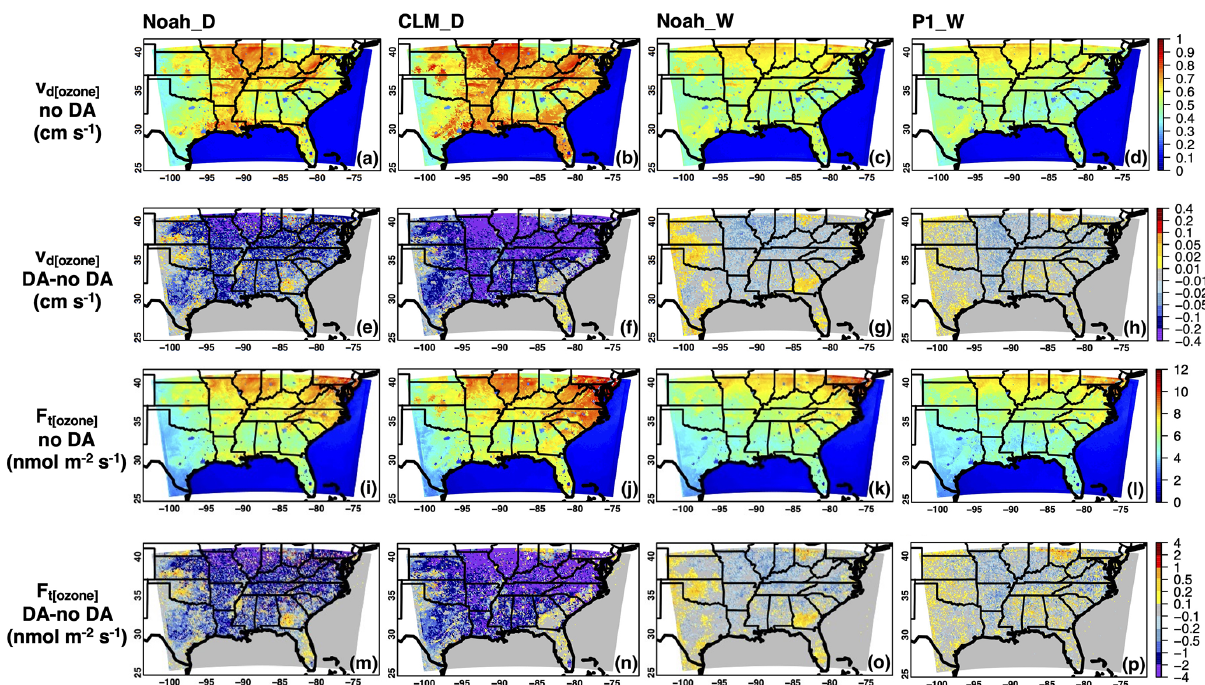
Figure 7. Period-mean (16–28 August 2016) WRF-Chem (a–d) O 3 dry-deposition velocity and (i–l) O 3 dry-deposition flux, as well as (e–h, m–p) the impacts of SMAP DA on these model fields. Results are shown for (a, e, i, m) Noah_D, (b, f, j, n) CLM_D, (c, g, k, o) Noah_W, and (d, h, l, p) P1_W cases, averaged throughout the